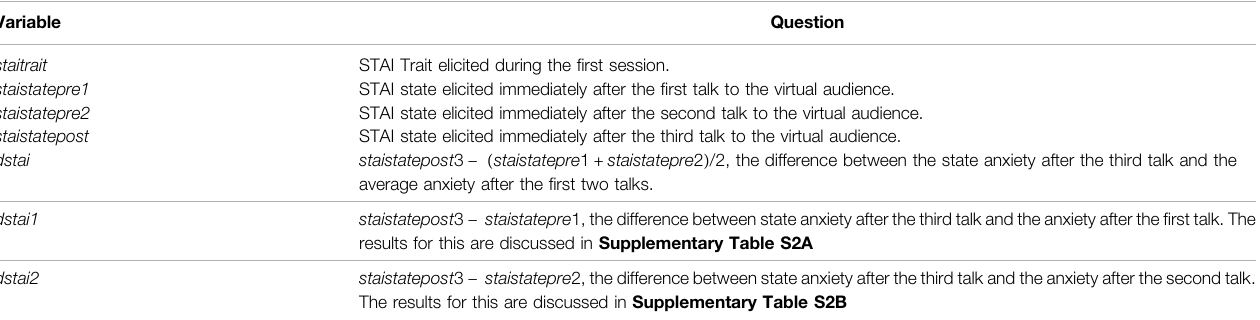
TABLE 2 | Theanxiety scores.In general “ traitanxiety ” refers toastable attribute ofpersonality,whereas “ state anxiety ” refers toanxiety withrespect toaparticular situation or event. The STAI refers to the State-Trait Anxiety Inventory questionnaire (Spielberger, 1983). Variable